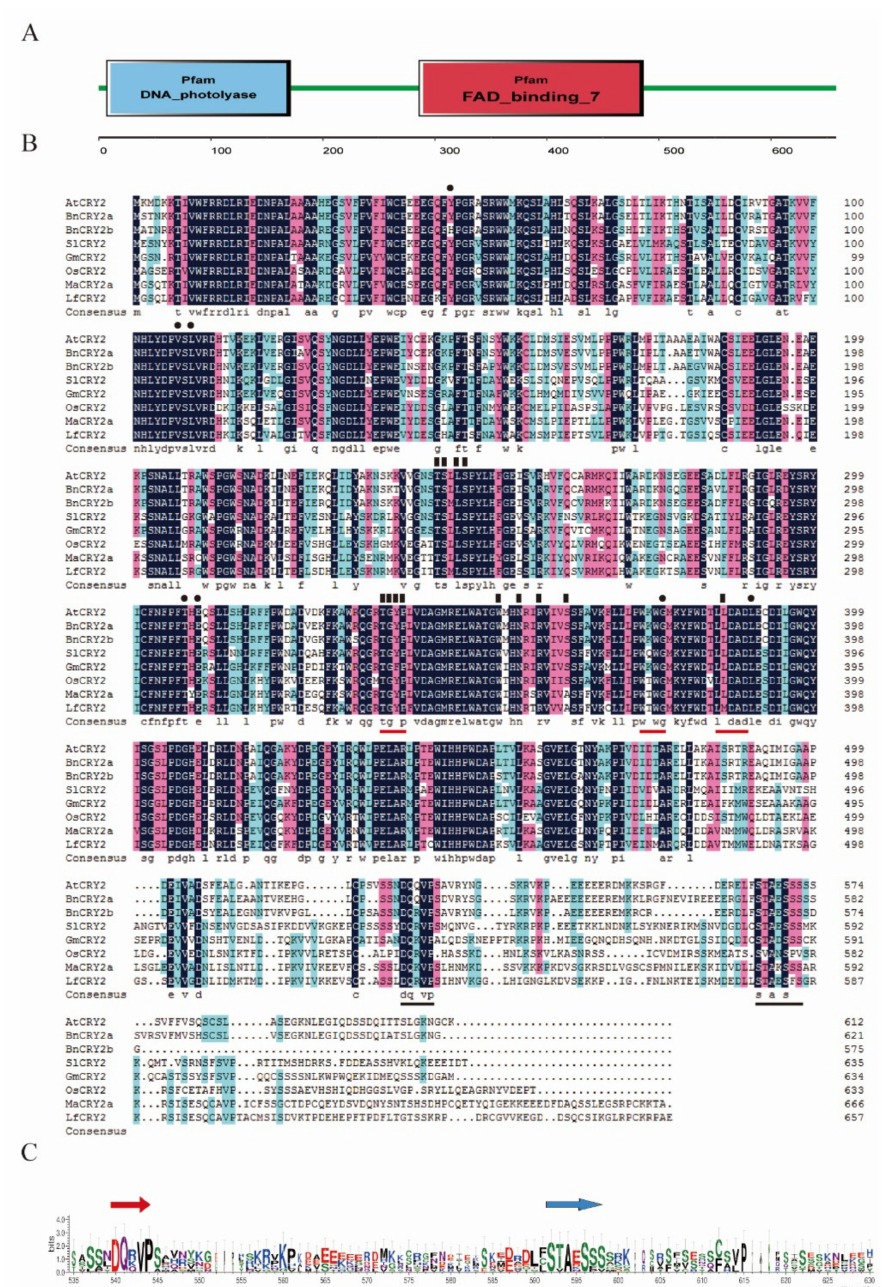
Figure 1. Analysis of LfCRY2 protein sequence. ( A ) Structural domains of the LfCRY2 protein. Analysis of protein sequences by SMART program. ( B ) Amino acid sequence alignment of cryp- tochrome proteins from Arabidopsis , Brassica napus , Solanum lycopersicum , Glycine max , Oryza sativa , and Musa acuminate . The alignment was constructed using DNAman version 5.2.2 software. Identical residues are highlighted by black boxes. Red lines under the sequences indicate the TGYP, WRWK, and LLDAD motifs. Black lines above the sequences indicate the DQMVP-E/D-STAESS (DAS) domain located in the C-terminal region. Residues that interact with FAD and MTHF are indicated by black rectangles and black dots, respectively. ( C ) DAS domain sequence logos. The sequence alignment of the domains was generated using ClustalX, and conserved motif logos were created using the WebLogo program (http://weblogo.threeplusone.com accessed on 31 October